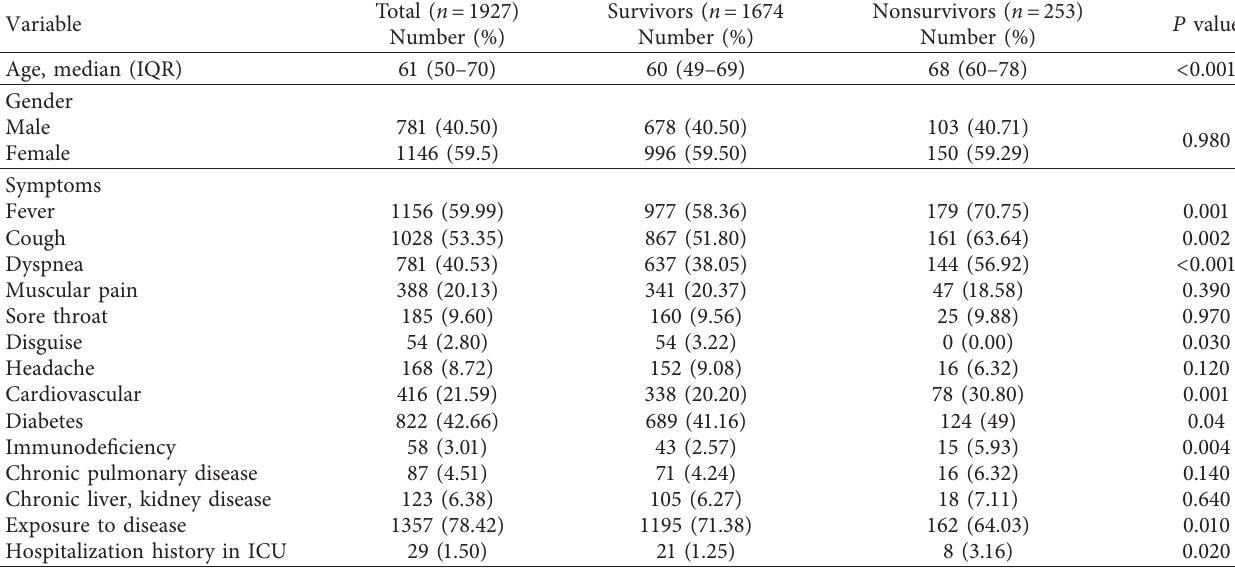
Table 2: The baseline characteristics of survivors and nonsurvivors in patients with COVID-19 with hypertension disease. Variable